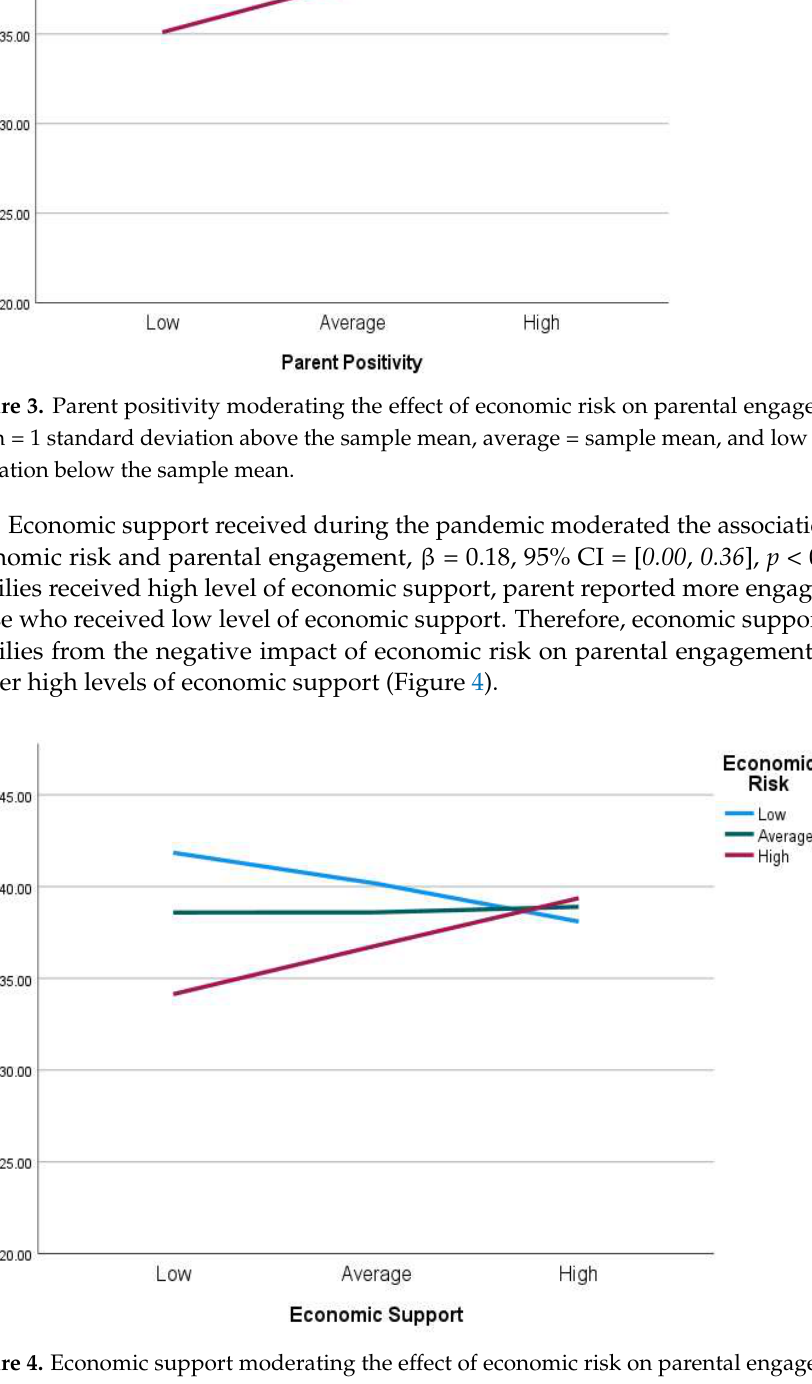
13 of 21 Figure 2. Associations between economic and social risks and family functioning. Note. All predic- tors are mean-centered. For parsimony, errors and non-significant coefficients are omitted from the figure. All standardized coefficients and covariances are significant at p < 0.05. 3.3. Moderation Effects To test for moderation effects, 6 interaction terms (economic risk x parent positivity, economic risk x coparenting support, social risk x parent positivity, social risk x coparent- ing support, economic risk x economic support, social risk x access to services and infor- mation) were added to the main effects model. We found two significant interactions. To further test the moderation effect, we used simple slopes analysis [94]. Parent positivity during the pandemic moderated the association between economic